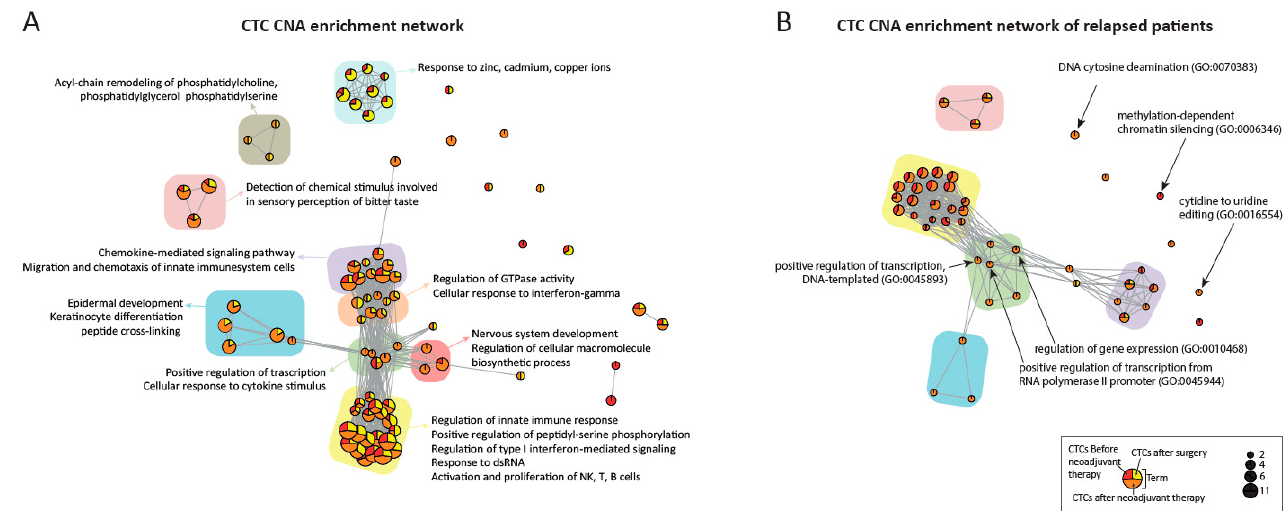
Figure 5. Networks on enriched GO (Biological Process) terms of CNAs of identified CTCs. GO terms are represented as nodes (circles). Sizing of the nodes is based on the number of CTCs with enriched term. Every circle is divided into sectors representing a proportion of the clinical step where CTCs were been identified: red, orange sectors before and after neoadjuvant therapy, respectively, yellow after surgery; edges (grey lines) represent at least ten common genes overlapping the two terms. Network on enriched GO terms of all identified CTCs ( A ) and only of CTCs identified on relapsed patients ( B ). GO terms in the larger communities were color-coded accordingly. Colored rectangles behind nodes: activation and modulation of innate immune system (yellow), chemotaxis and migration of immune system cells (violet), sensory perception of bitter taste (pink), skin development (blue), modulation of the transcription (green), macromolecules biosynthesis/nervous system development (red), response to zinc/cadmium/copper ions (cyan), cellular response to interferon.gamma (orange), acyl-chain remodeling (olive). CTC: circulating tumor cells; GO: Gene Ontology; CNA: copy number aberration.